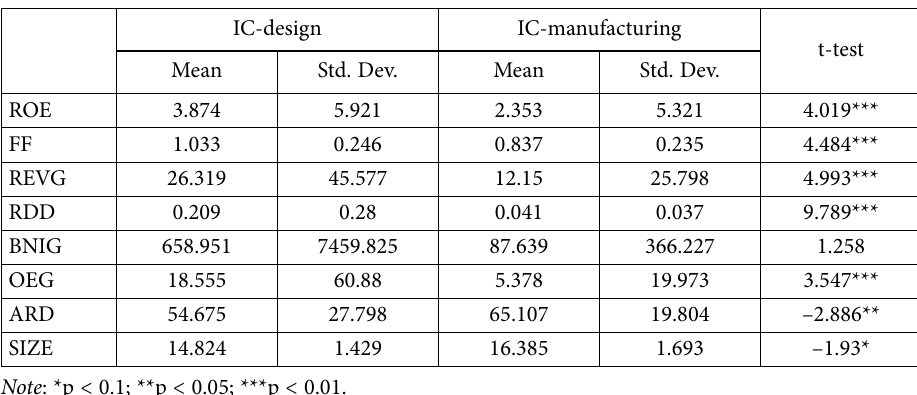
Table 3. Independent t-test for mean